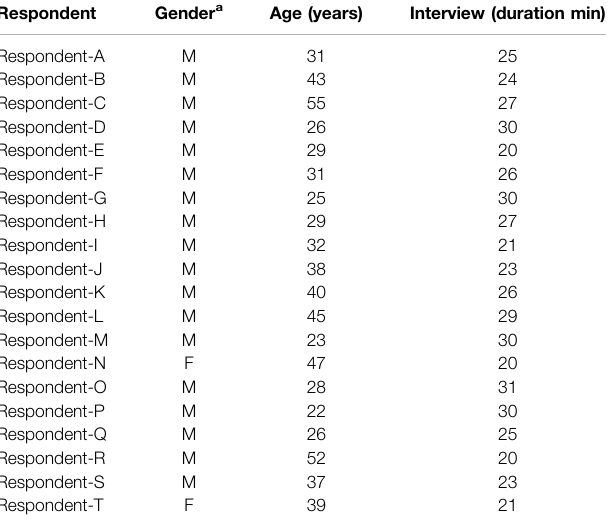
TABLE 2 | Respondents ’ (gender, age, and interview duration)